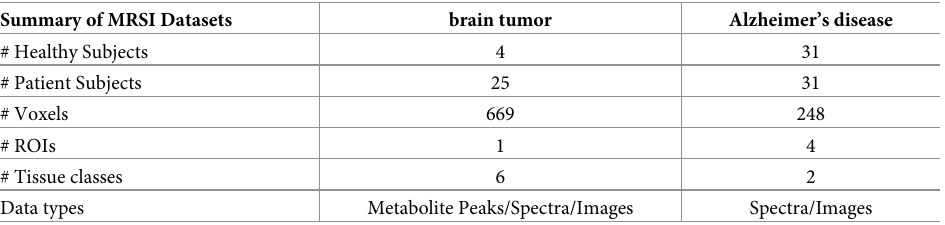
Table 1. Description of the MRSI datasets that have been used in our analysis. Metabolites peaks are quantified from MR spectra and these peaks correspond to brain metabolites. Spectra refer to MR spectra. Images refer to MR